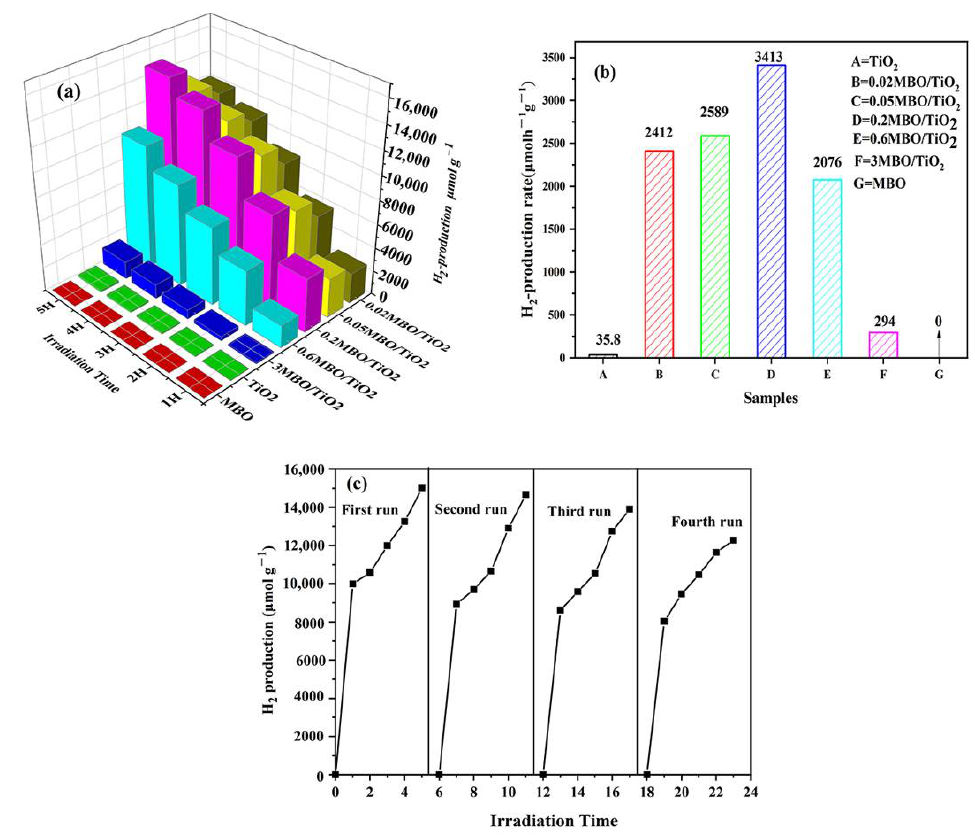
Figure 7. ( a ) Photocatalytic hydrogen generation, ( b ) the hydrogen generation rate of different samples under visible light irradiation, and ( c ) recycling tests for photocatalytic hydrogen generation of 0.2 MBO/TiO 2 . Table 1. A comparison of different TiO 2 composite photocatalysts for hydrogen production.